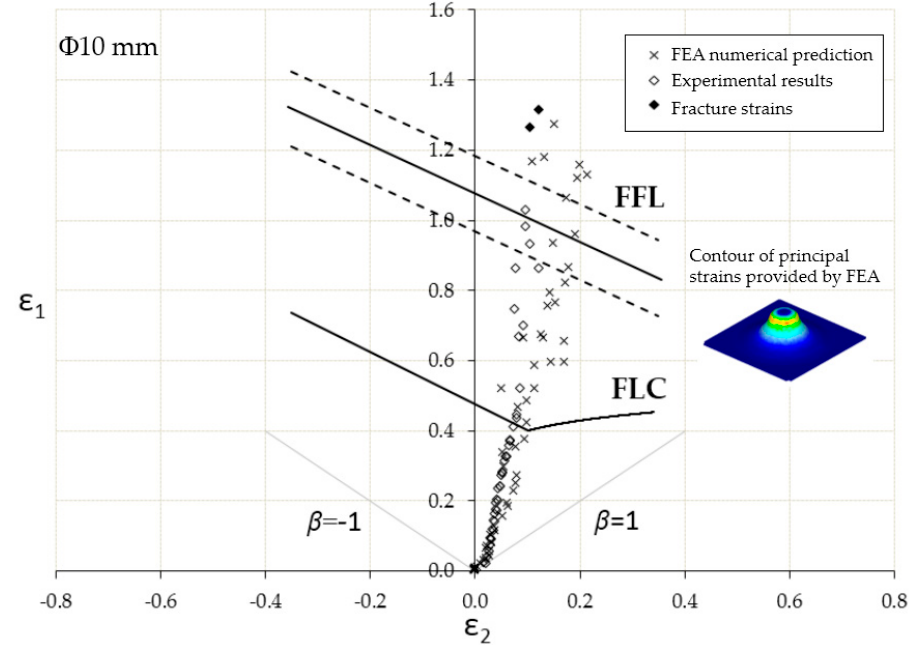
Figure 10. Numerical predictions versus experimental values of principal strains within the FLD of the material in the final testing part deformed by SPIF using a tool of Ф 10 mm diameter.